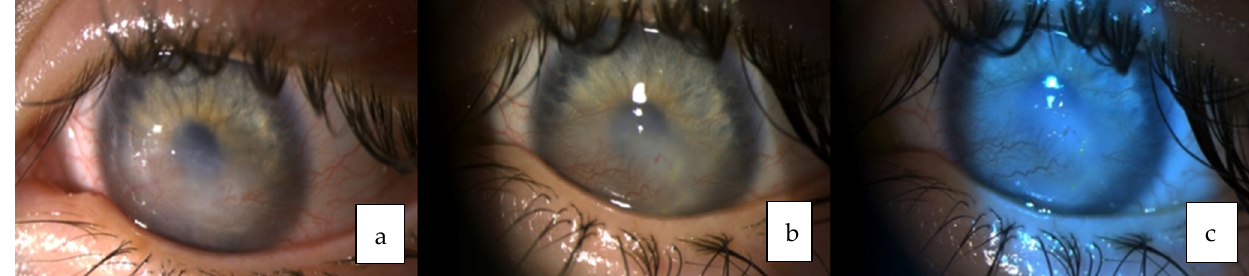
Figure 5. ( a ) Left eye before anti-VEGF subconjunctival injection. ( b , c ) Left eye after three anti-VEGF subconjunctival injection.